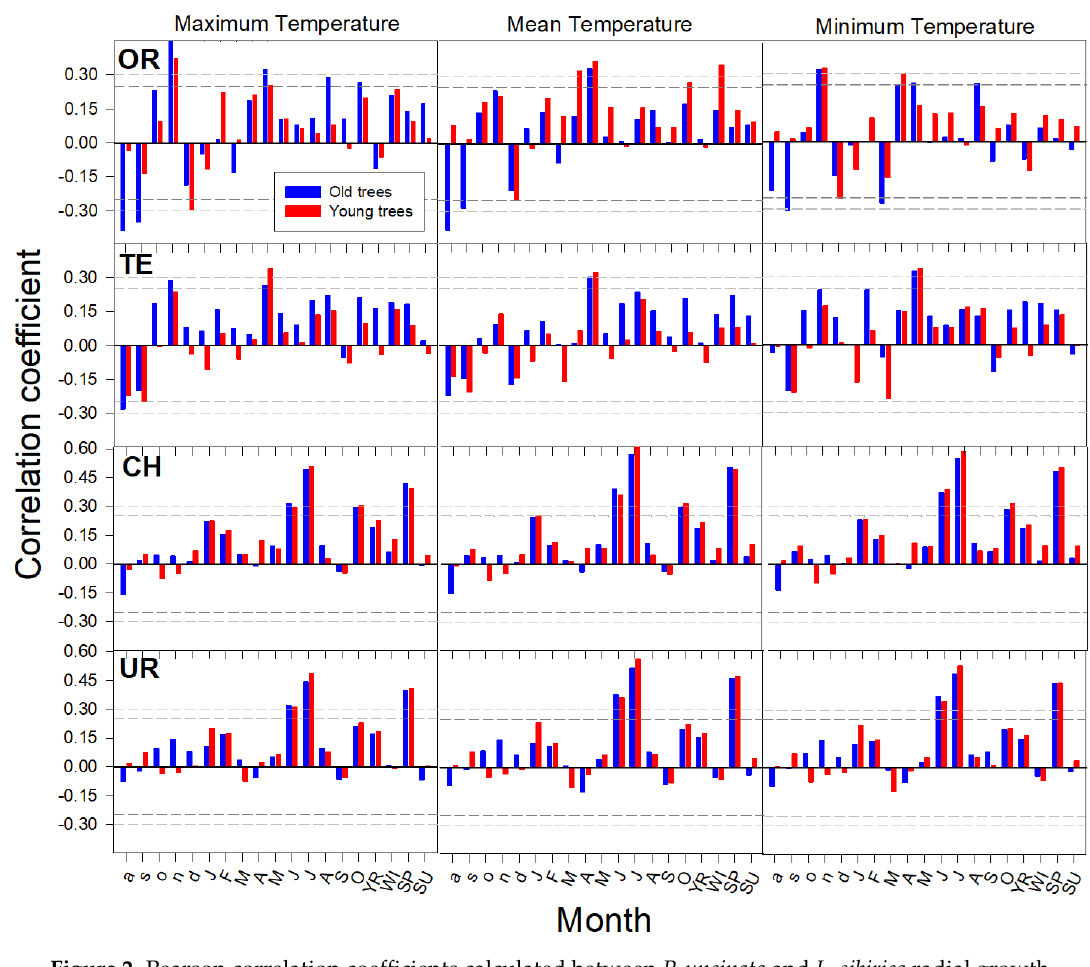
Figure 2. Pearson correlation coefficients calculated between P. uncinata and L. sibirica radial growth age groups (ring-width indexes) and the monthly mean, maximum and minimum temperatures for 1950–2012 in the Pyrenean treelines (OR, TE) and Ural treelines (CH, UR). Growth is related with climate data from the previous (months abbreviated by lowercase letters) and current (months and seasons (YR, annual; WI, winter; SP, spring; SU, summer) abbreviated by uppercase letters) years, the current year being that of tree-ring formation. The significance levels of correlation coefficients are indicated by dashed dark grey lines ( p < 0.05) and light grey horizontal lines ( p < 0.01). Moving correlations between radial growth and the significant temperatures showed a noticeable shift in the 1980s with changes from negative to positive values for July minimum temperature in L. sibirica treelines, higher in young trees than in old ones (Figure 3). The influence of minimum May temperature on P. uncinata growth decreased more in OR than in TE Pyrenean treelines. In contrast, previous November temperatures were playing opposite roles by enhancing or decreasing growth since 1980s in OR and TE sites, respectively.